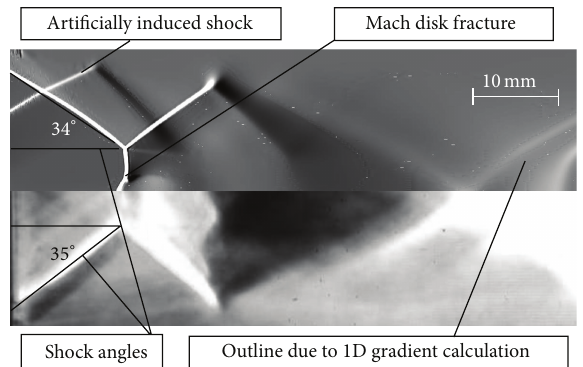
Figure 11: Comparison of CD schlieren images in the GOX flow condition.